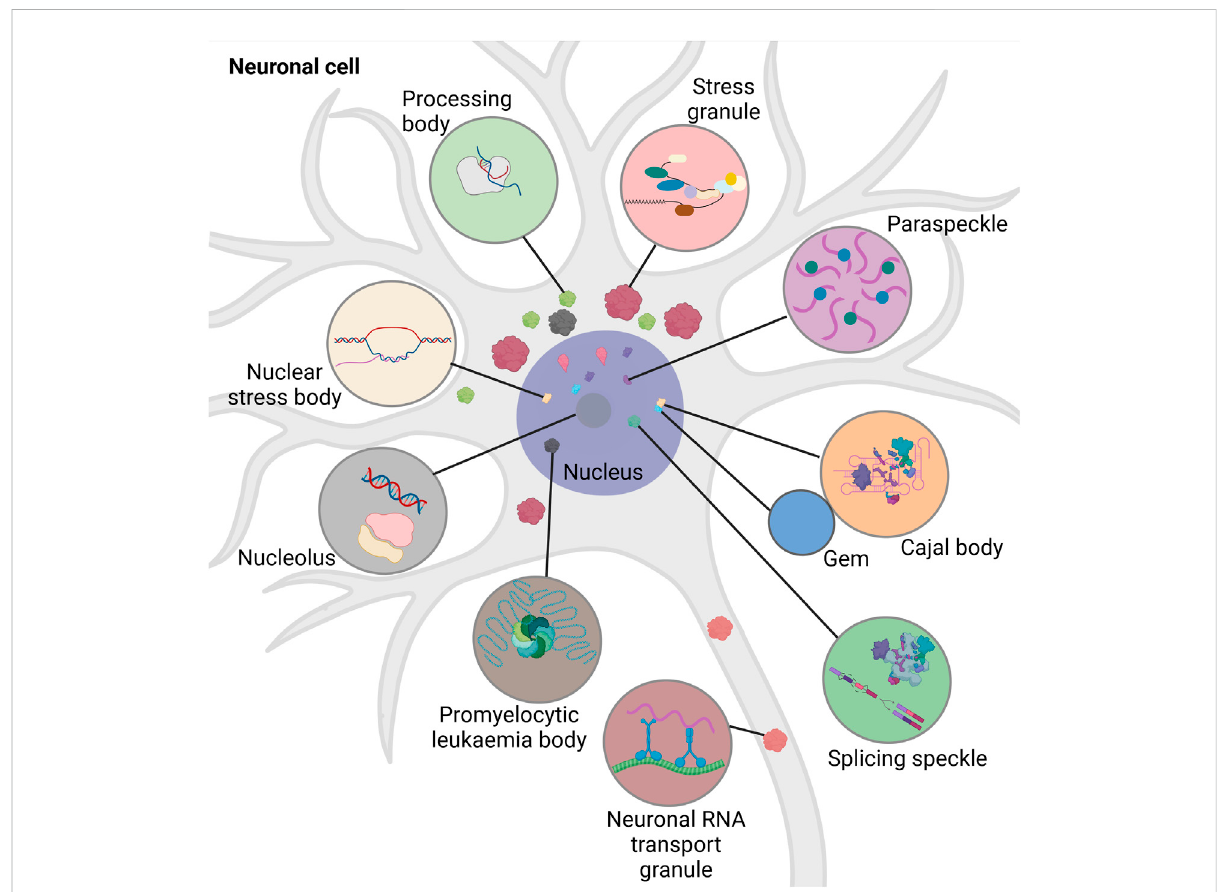
FIGURE 1 Schematic overview of different types of intracellular RNA granules in neuronal cell. Promyelocytic leukemia bodies belong to the nuclear granules. Nuclear granules (nucleus dark purple) include nuclear stress bodies (beige, sites of reprogramming of gene expression), Cajal bodies (orange, sites of RNA-processing), Gems (blue, Cajal body assistance), splicing speckles (green, sites of splicing factor modi fi cation and storage), paraspeckles (purple, sites of RNA-retention) and the nucleolus (dark grey, site of ribosomal synthesis). Cytoplasmic granules include stress granules (red, sites of translational block), neuronal RNA transport granules (brown, sites of neuronal RNA-transport), and processing bodies (light green, sites of RNA-storage and -decay). Created with